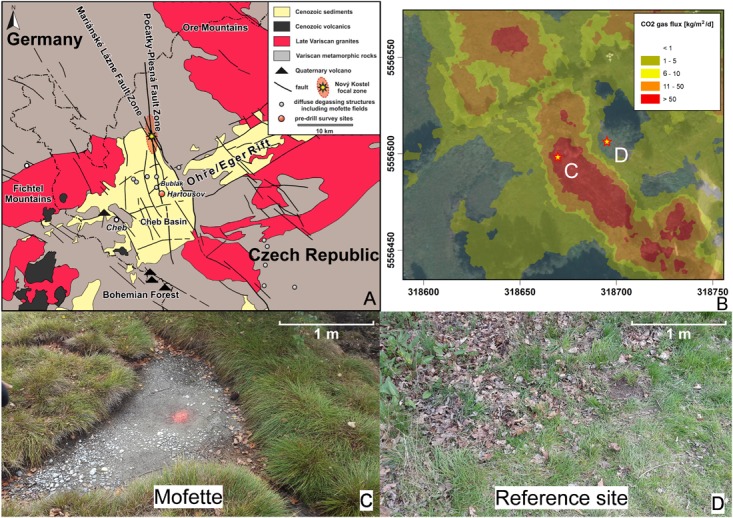
Geological map of the Cheb Basin (modified from Flechsig et al., 2008) (A), CO2 gas flux in the Hartoušov mofette field (modified from Nickschick et al., 2015, coordinates in UTM 33N) (B), surface at the mofette (C) and the reference site (D). The drilling locations are marked by stars (C = mofette site; D = reference site) in the CO2 gas flux map (B).